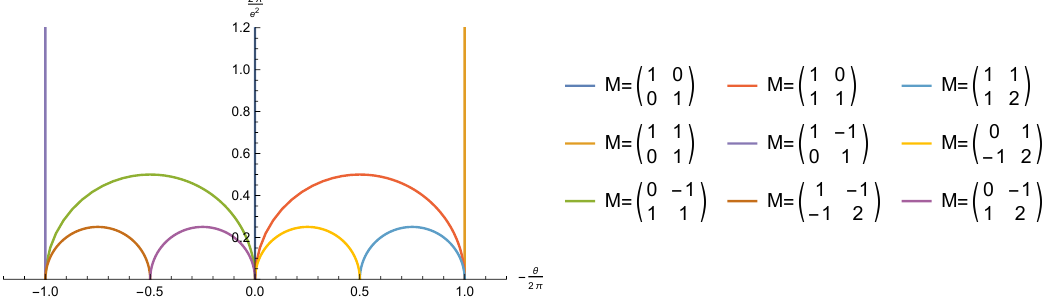
Figure 1 . Mapping of theories in the complex τ plane that are related by different elements of SL (2 , Z ) . On the vertical axis we plot Im τ = 2 π/e 2 and on the horizontal axis Re τ = − θ/ 2 π . Theories that have θ = 0 and thus can be directly simulated are located on the positive vertical axis (marked with a thick black line). Different elements of SL (2 , Z ) map this family of theories to equivalent theories with non-zero θ which are represented by the semi-circles (see the legend for which element M of SL (2 , Z ) was